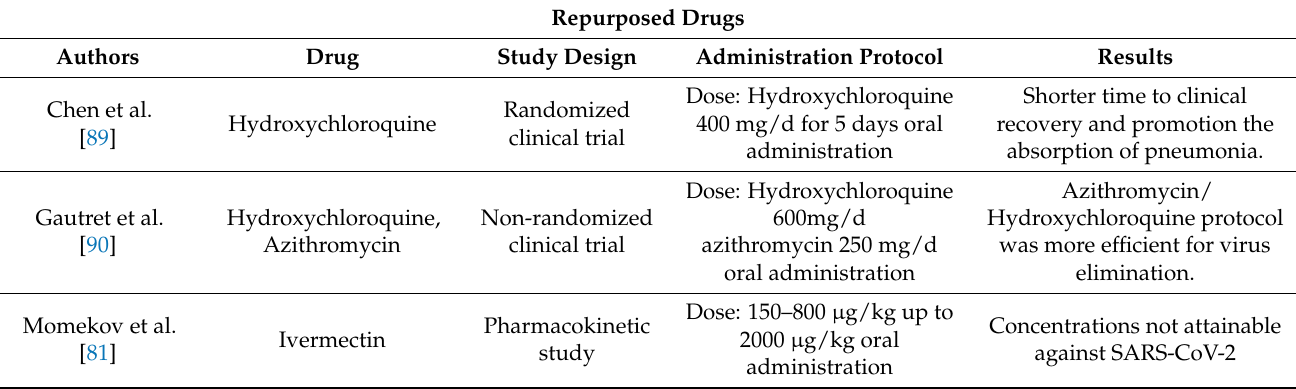
Table 3. Summary of the in vivo studies included about repurposed antimalarial drug therapies for viral